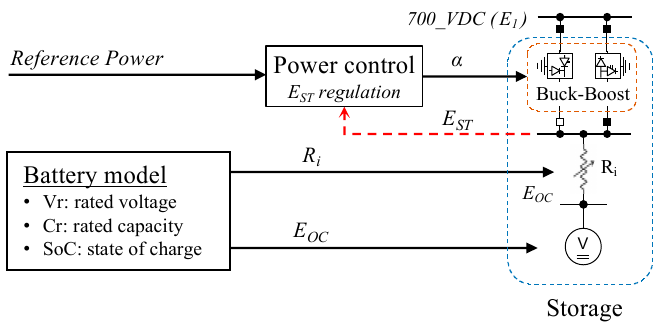
Figure 6. Battery model developed in DIgSILENT PowerFactory to emulate the behavior of the storage system as a function of the SoC and the required power exchange.